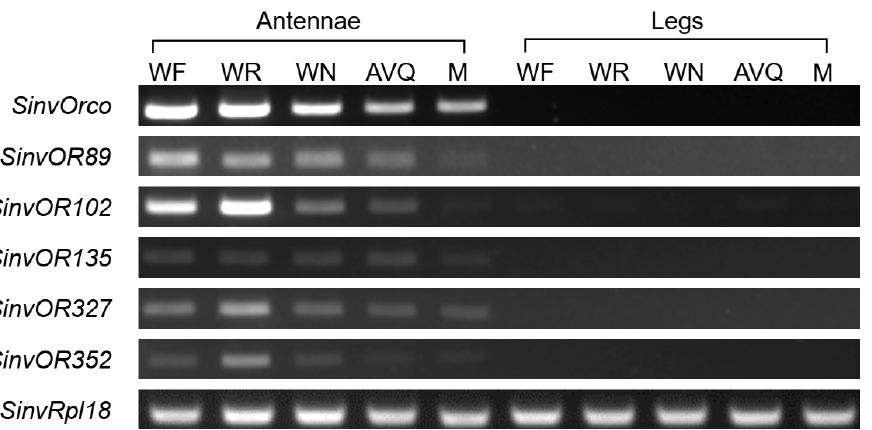
Figure 7. Tissue- and caste-specific expression levels of the conserved ORs in S. invicta . RT-PCR analysis of OR gene expression was performed for antennae (A) and legs (L) of individuals from five castes of S. invicta , namely worker for foragers (WF), worker for reserves (WR), worker for nurses (WN), alate virgin queen (AVQ), and males (M). The Orco gene was used as the positive control. Rpl18 was used as a reference gene.